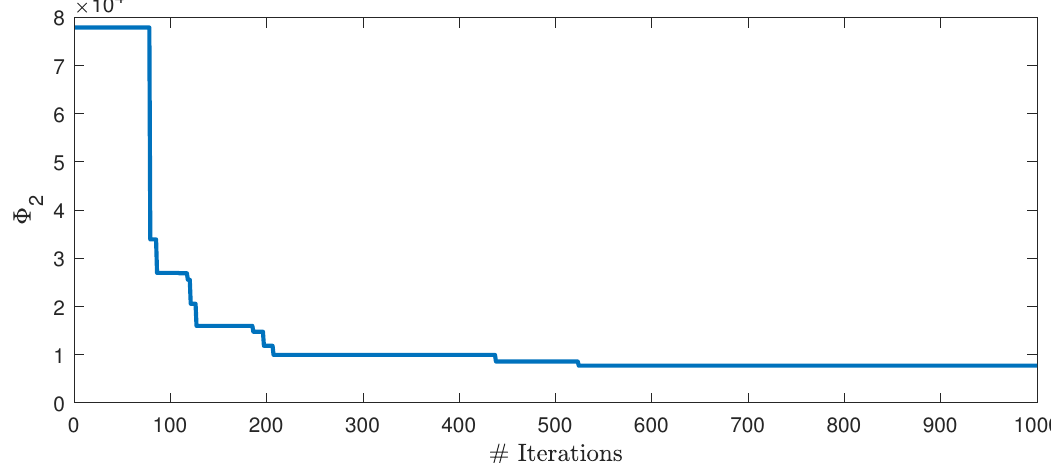
Figure 12. Computed convergence of the solving process in terms of Φ 2 (energy consumption), similar to Figure